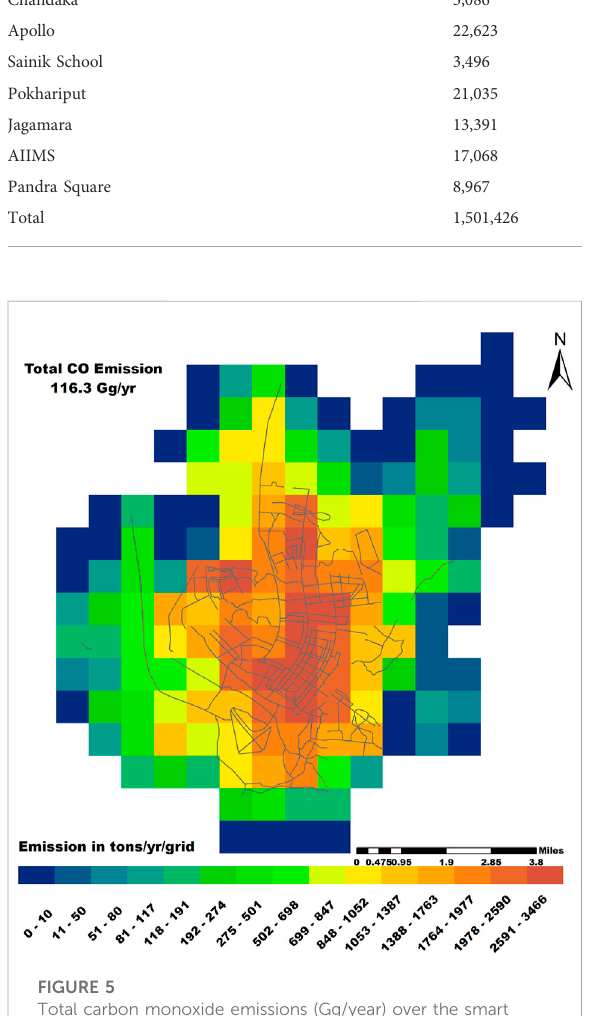
FIGURE 5 Total carbon monoxide emissions (Gg/year) over the smart city of Bhubaneswar for the year 2018 for 1 km × 1 km resolution, considering the transportation sector.